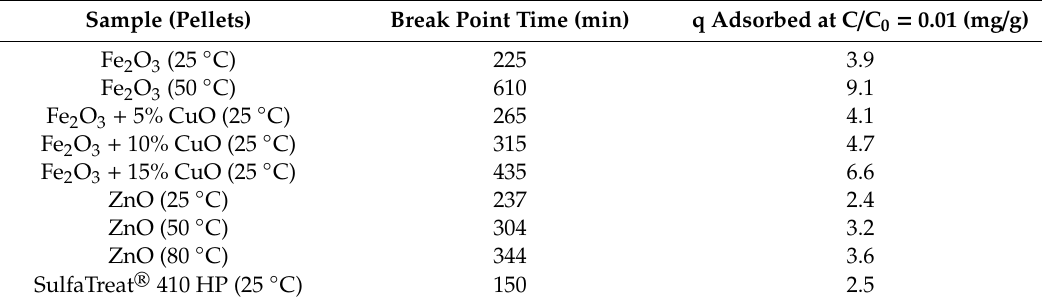
Table 3. Summary of pellet properties and their comparison with other commercial sorbents. The values concerning SulfaTreat ® have been calculated using the data taken from